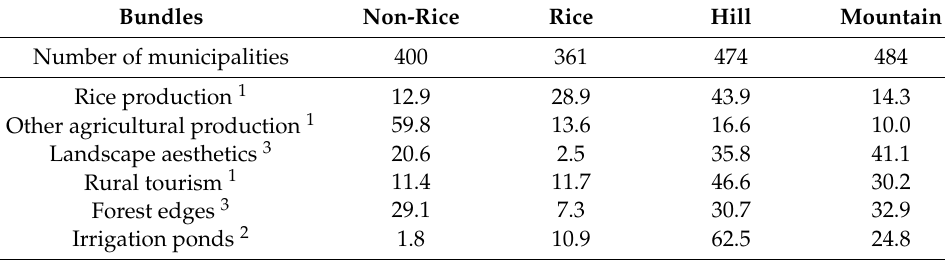
Figure 2. Results of cluster analysis showing: ( a ) spatial distributions of ecosystem service bundles and ( b ) average values of ecosystem services and biodiversity found within each bundle represented in flower diagrams. The number of municipalities per bundle is shown in parentheses next to the bundle names. Table 3. Percent share of ecosystem services and biodiversity in total for each ecosystem service bundle.